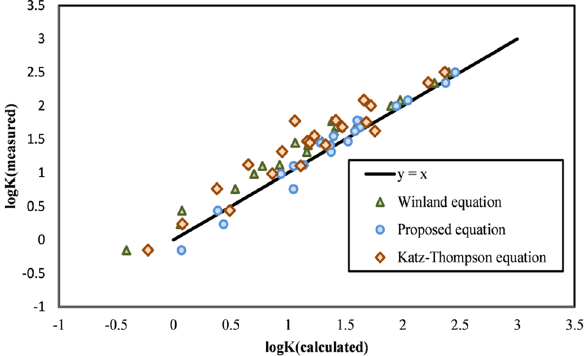
Fig. 9 Cross-plot of the measured and the calculated permeabilities for the proposed, Winland, and Katz and Thompson equations (car- bonate samples)